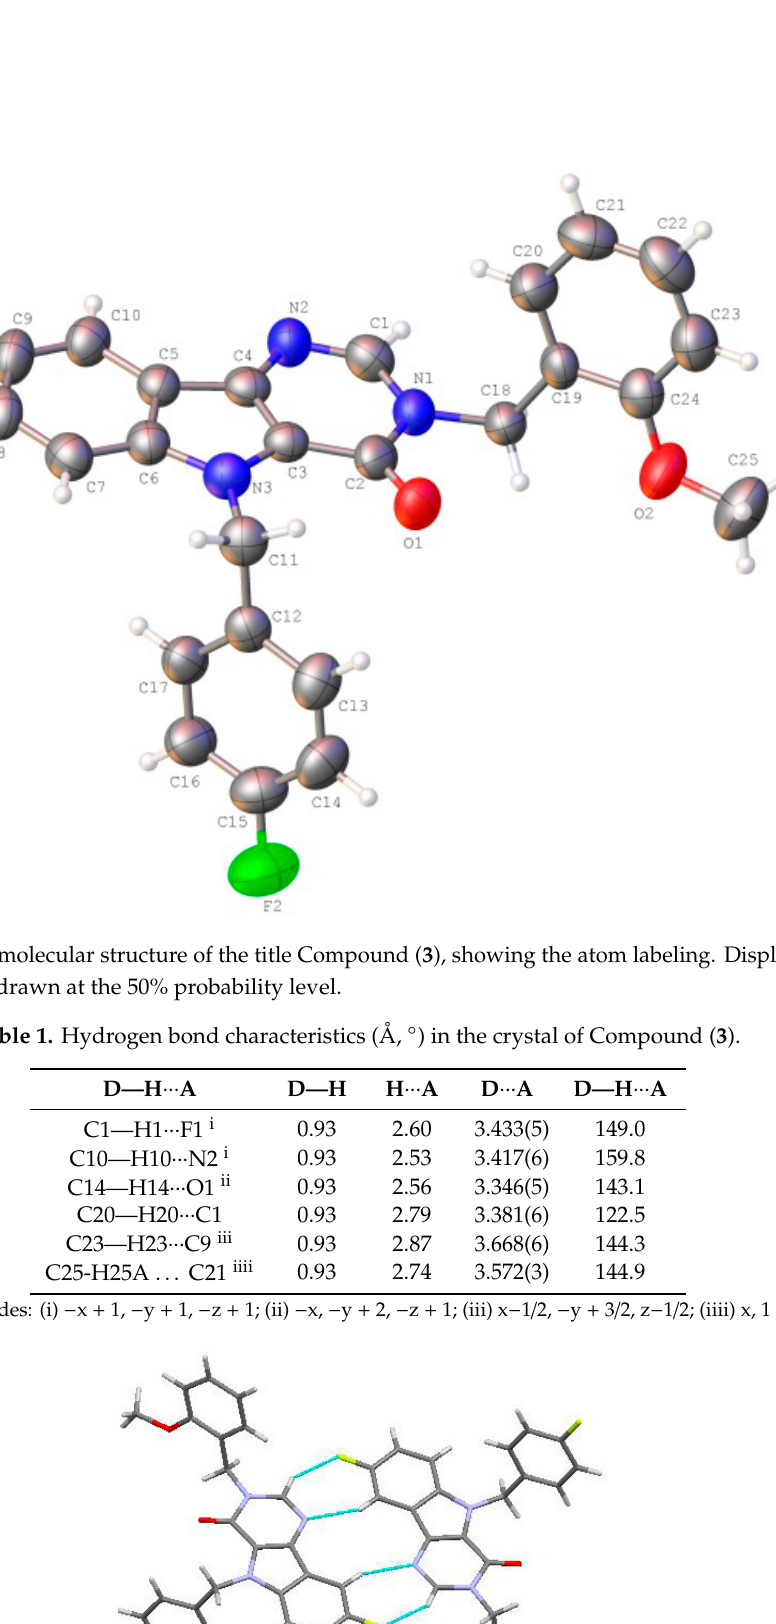
Figure 3. Centrosymmetric dimer in the crystal of titled Compound ( 3 ).